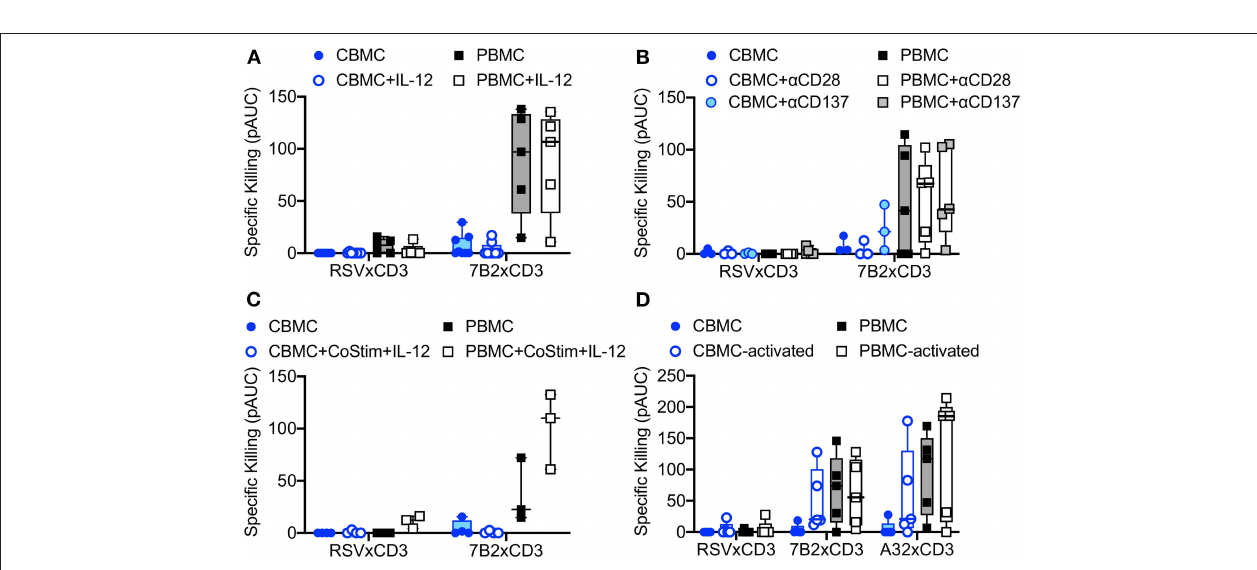
FIGURE 3 | Redirection of cord blood mononuclear cell (CBMC)-derived cytolytic T cells for elimination of autologous HIV-1 infected CD4T cells by HIV × CD3 DART molecules is not improved by incubation with (A) 10ng/mL exogenous IL-12 (CBMC n = 8, PBMC n = 5), (B) costimulation with anti-CD28 or anti-CD137 antibodies (CBMC n = 3, PBMC n = 5), or (C) a combination of costimulation with anti-CD28 and anti-CD137 (CoStim) and exogenous IL-12 (CBMC n = 4, PBMC n = 3). (D) HIV × CD3 DART molecule-mediated elimination of autologous HIV-1-infected CD4 + T cells is improved when CD8 + T cells used as effectors are activated by T cell receptor stimulation (anti-CD28, anti-CD3, and IL-2) for 48h prior to use in the cell killing assays (CBMC and PBMC n = 5). Box plots represent the interquartile ranges, horizontal lines indicate the medians, and error bars extend to the minimum and maximum observed values. 24h killing assays with a CD8 + effector to HIV-1 4403bmC5-infected autologous CD4 + target cell ratio of 30:1. All data reported as positive area under the dilution curve (pAUC).